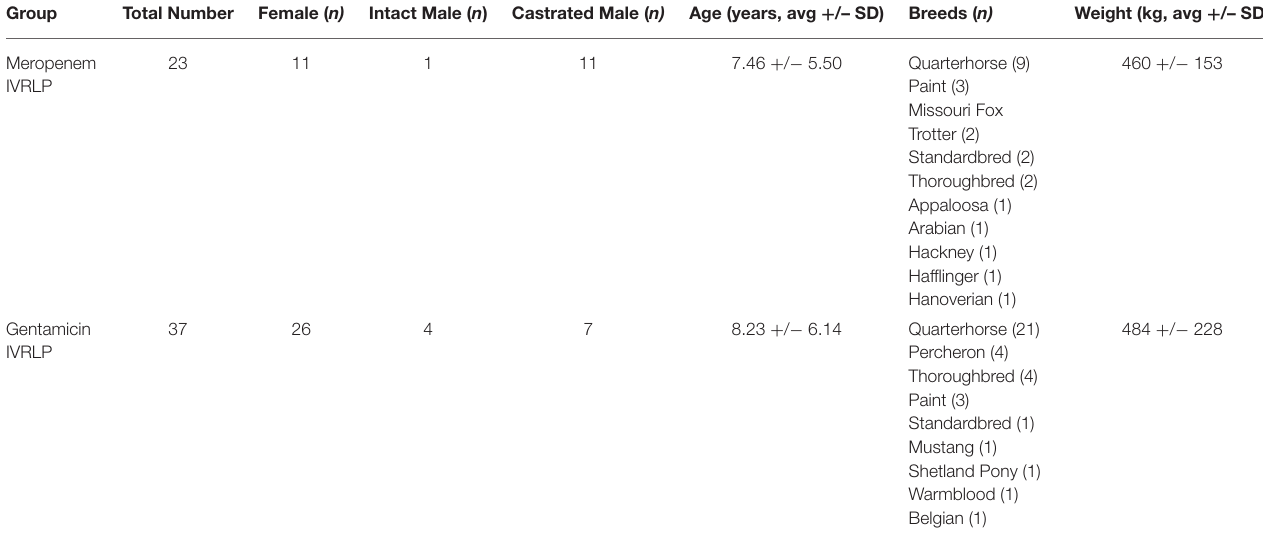
TABLE 1 | Demographic information for horses administered either meropenem or gentamicin via intravenous regional limb perfusion (IVRLP).